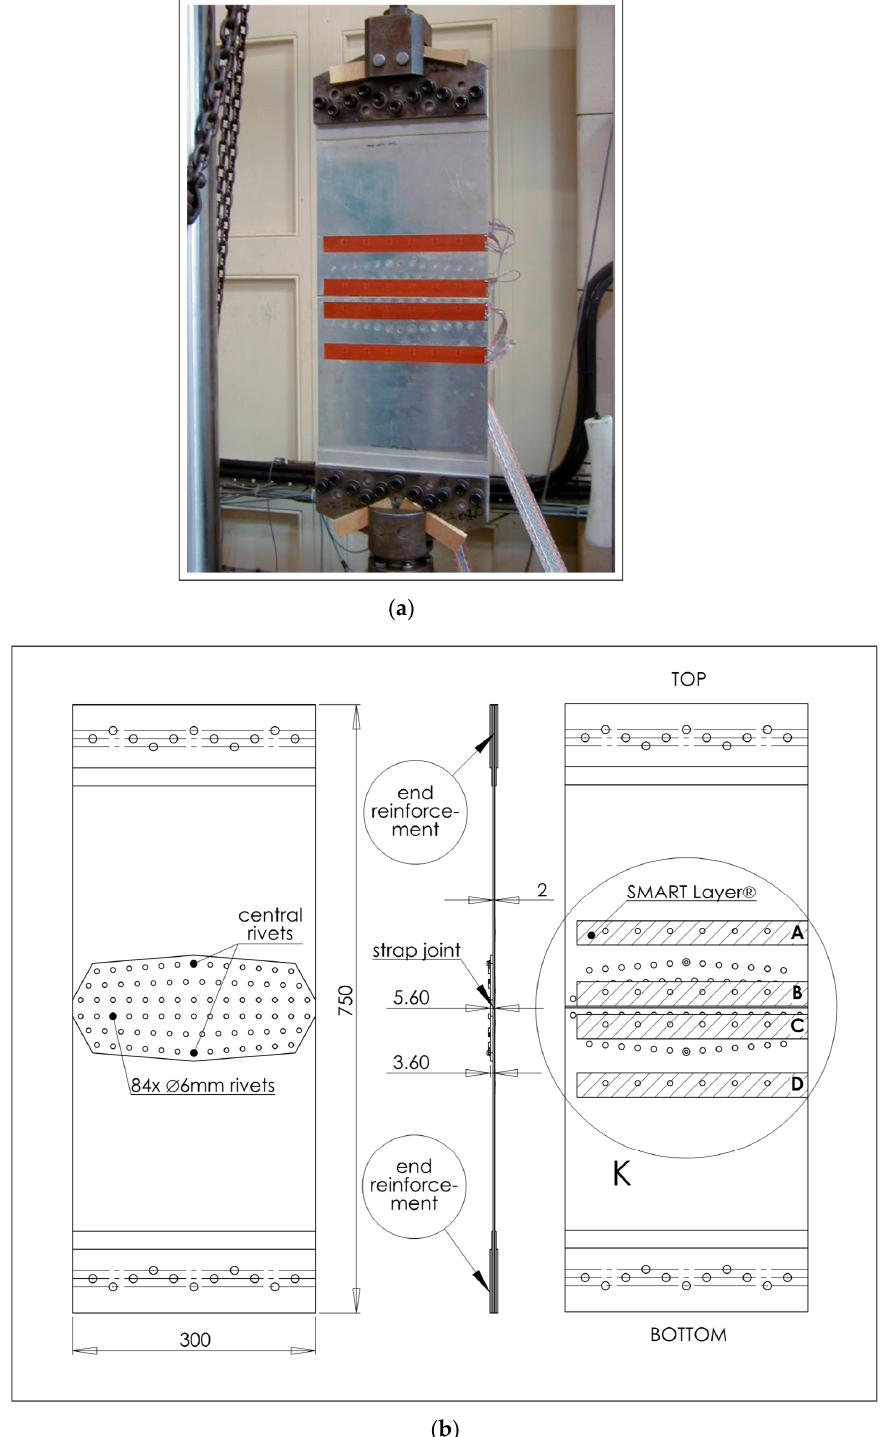
Figure 1. Multi-riveted strap joint aluminium panel with bonded A, B, C and D SMART Layer ® transducers: ( a ) general view; ( b ) geometry and dimensions; circle K gives transducer locations that are given in details in Figure 2.